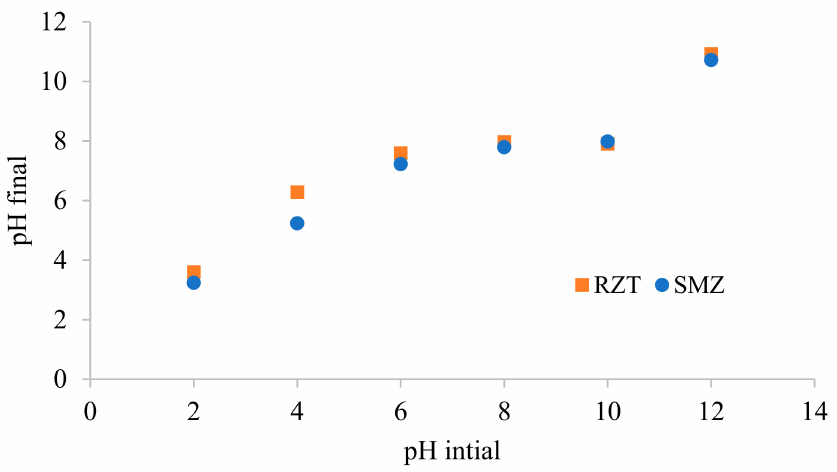
Figure 1. Point zero net charge for raw zeolitic tuff (RZT) and surfactant modified zeolite